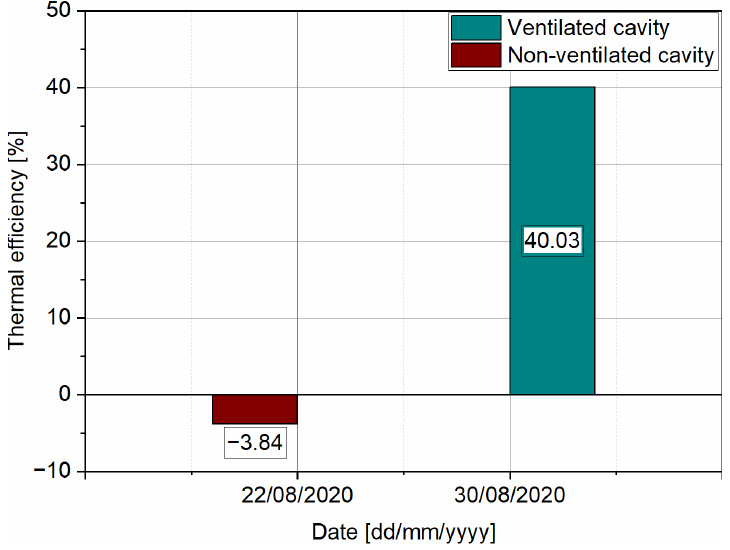
Figure 16. BIPV-WS thermal efficiency behavior for summer conditions.